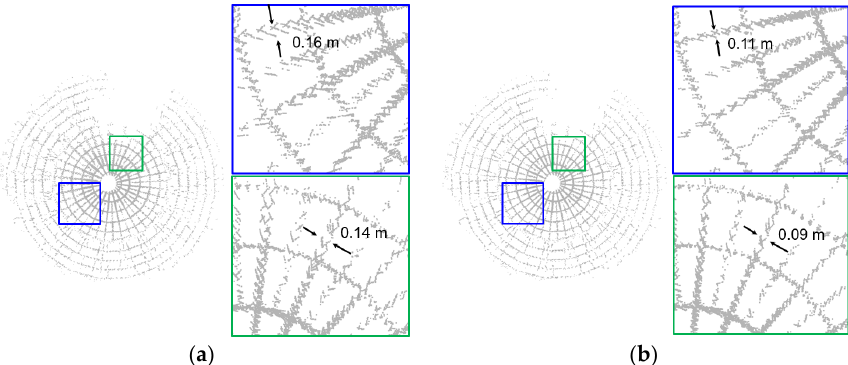
Figure 35. Extracted edge points from all scans of the Lebanon dataset ( a ) before and ( b ) after full fine registration.